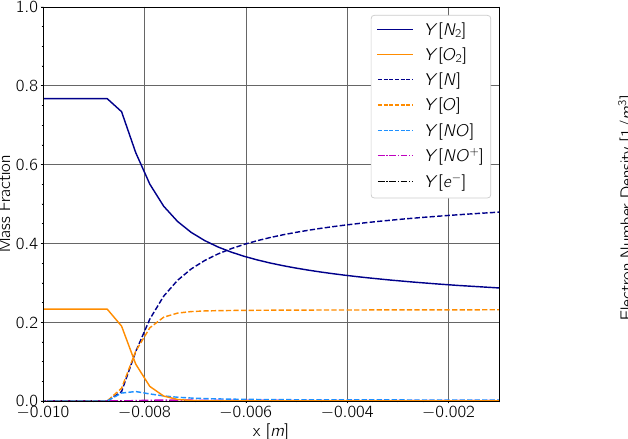
Figure 8. Flow contours around RAM-C vehicle forebody.